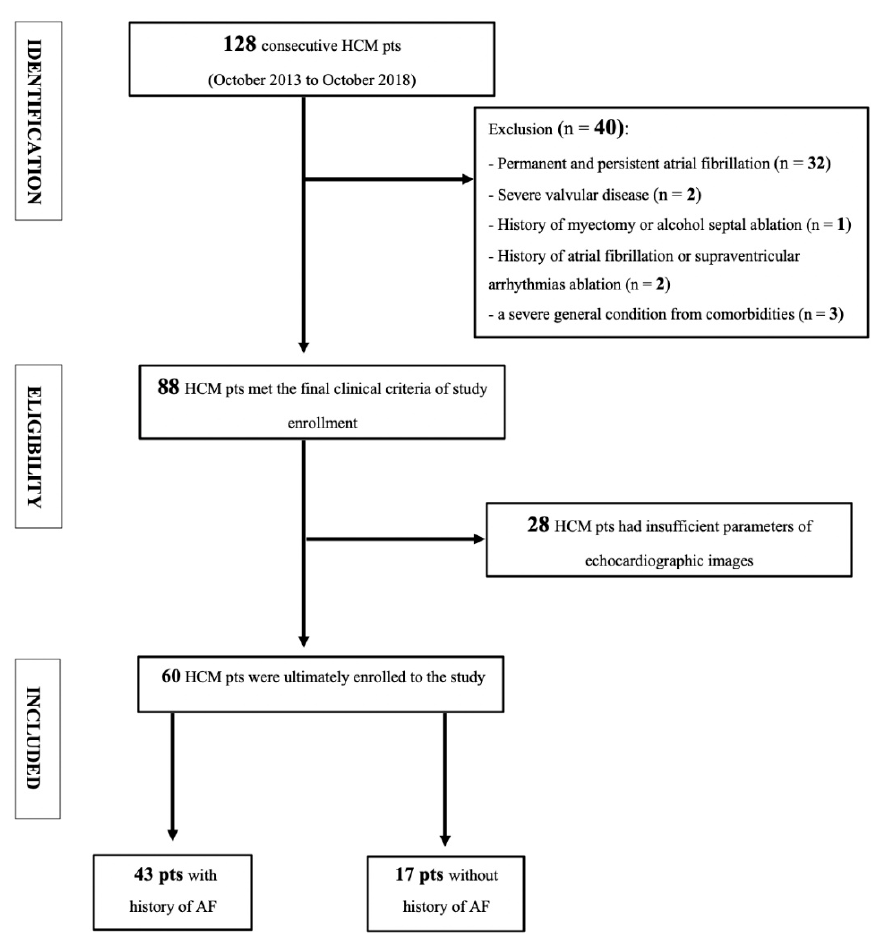
Figure 1. Flow chart of screened, included, and excluded HCM patients. Among standard echocardiography, LADs, LAA index, LAV index, and diastolic Table 1. Clinical characteristics of HCM AF+ and AF − patients. function parameters (Em and E/Em) differed significantly between HCM patients and healthy persons; regarding the comparison between AF+ and AF − patients, the only parameter significantly differed between the two groups was LVEF, which was lower in AF+ patients (Table 2). The accurate measurement of the 2D LV GLS was able to perform in every included patient; the reliable analysis of LA strain was possible in 43 patients, whereas 3D LV strains were accurately measured in 45 patients. Most of the advanced echocardiographic parameters regarding LA and LV were worse in HCM patients than in healthy volunteers. Comparing AF+ and AF − groups, strain parameters for LV were significantly lower in AF+ patients (Table 2). Figures 2–5 represent the examples of LA and LV strain analysis in HCM patients with FA diagnosis, without a history of FA, and a healthy